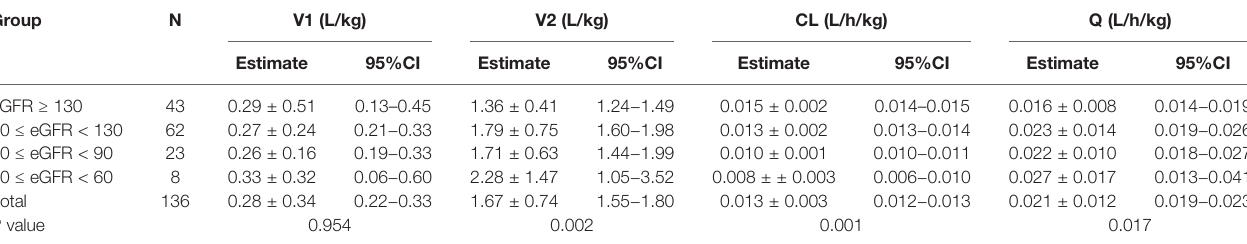
TABLE 5 | Pharmacokinetic parameters of groups with various renal function status estimated with Bayesian method (n = 136, mean ± SD). Group N V1 (L/kg) V2 (L/kg) CL (L/h/kg) Q (L/h/kg) Estimate 95%CI Estimate 95%CI Estimate 95%CI Estimate